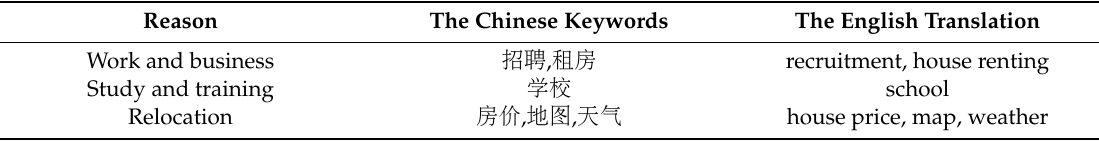
Table 2. Selection of search